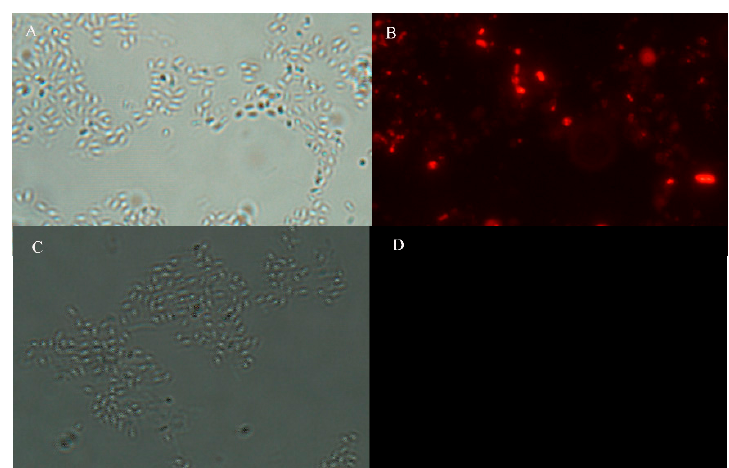
Figure 8. Immunofluorescence microscopy analysis: ( A , B ) recombinant B. subtilis BV; ( C , D ) B. subtilis 168; ( A , C ) bright-field images; ( B , D ) immunofluorescent images (10 × 100).